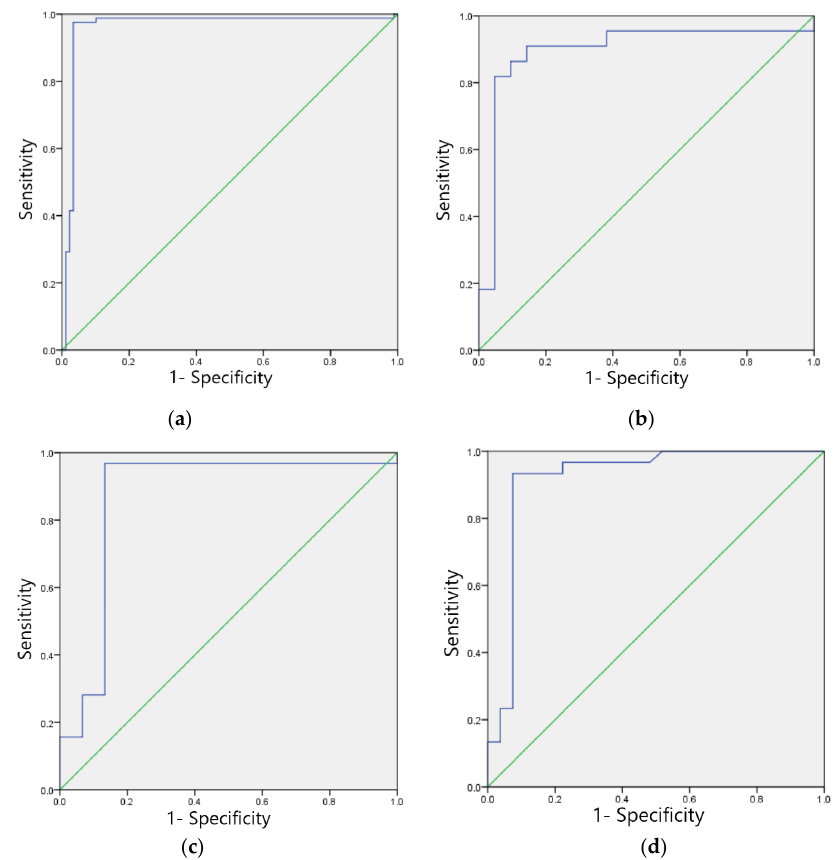
Figure 8. ROC curves for four typical anomaly categories of test sets: ( a ) Sinus bradycardia; ( b ) Sinus tachycardia; ( c ) Myocardial ischemia; ( d ) Nonspecific intraventricular conduction delay . Table 8. Evaluation of the effect of the ECG category recognition test set.